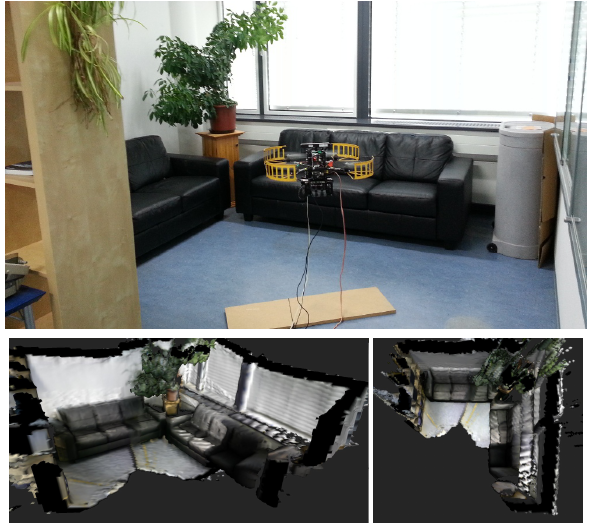
Figure 5: Path following experiment (rectangle). Blue: Estimated position of the quadrocopter. Red: Waypoints. As can be seen from this plot, the quadrocopter follows accurately and robustly the commanded trajectory for several rounds.